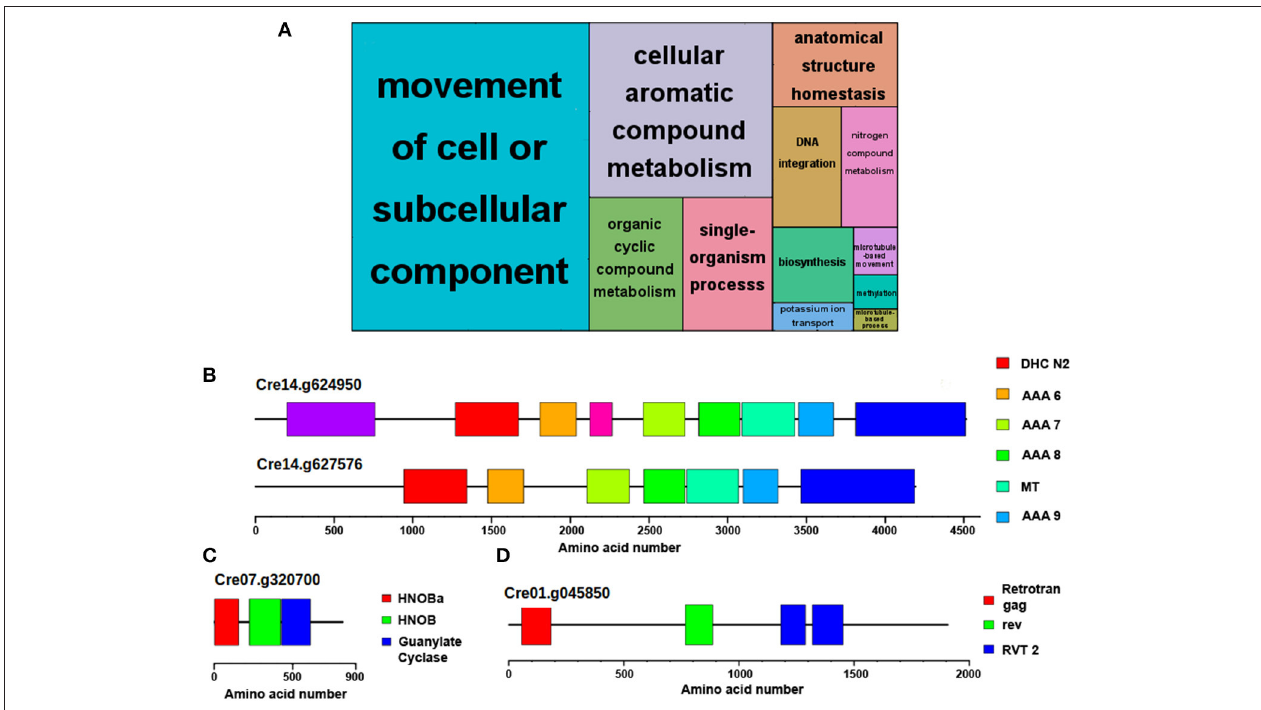
FIGURE 2 | Functional annotation of genes exclusively identified in Chlamydomonas . No potential Ostreococcus or Arabidopsis orthologues were identified for 15% of Chlamydomonas proteins. (A) Non-redundant GO term enrichment analysis over the set of Chlamydomonas genes with no potential orthologue in the other species, suggesting that they are mainly involved in “ movement of cell or subcellular component ,” “ organic cyclic compound metabolism, ” and “ DNA integration ”. Each rectangle area in the treemap represents the log10 ( p -value) for the corresponding GO-term. (B) Domain structure of the proteins encoded by Flagellar inner − arm dynein 1 (Cre14.g624950) and axonemal dynein heavy chain 6 (Cre14.g627576), two Chlamydomonas -specific flagellar proteins absent in Ostreococcus and Arabidopsis involved in “ movement of cell ” or “ subcellular component. ” (C) Domain structure of class III guanylyl and adenylyl cyclase encoded by CYG11 (Cre07.g320700), a Chlamydomonas -specific protein involved in “ organic cyclic compound metabolism .” This protein shows a higher homology to animal cyclases than to plant ones. (D) Domain structure of the protein encoded by gag-pol-related retrotransposon (Cre01.g045850), an example of Chlamydomonas specific proteins associated to the “ DNA integration ” GO term. Color boxes represent domains identified in pfam database including their identification